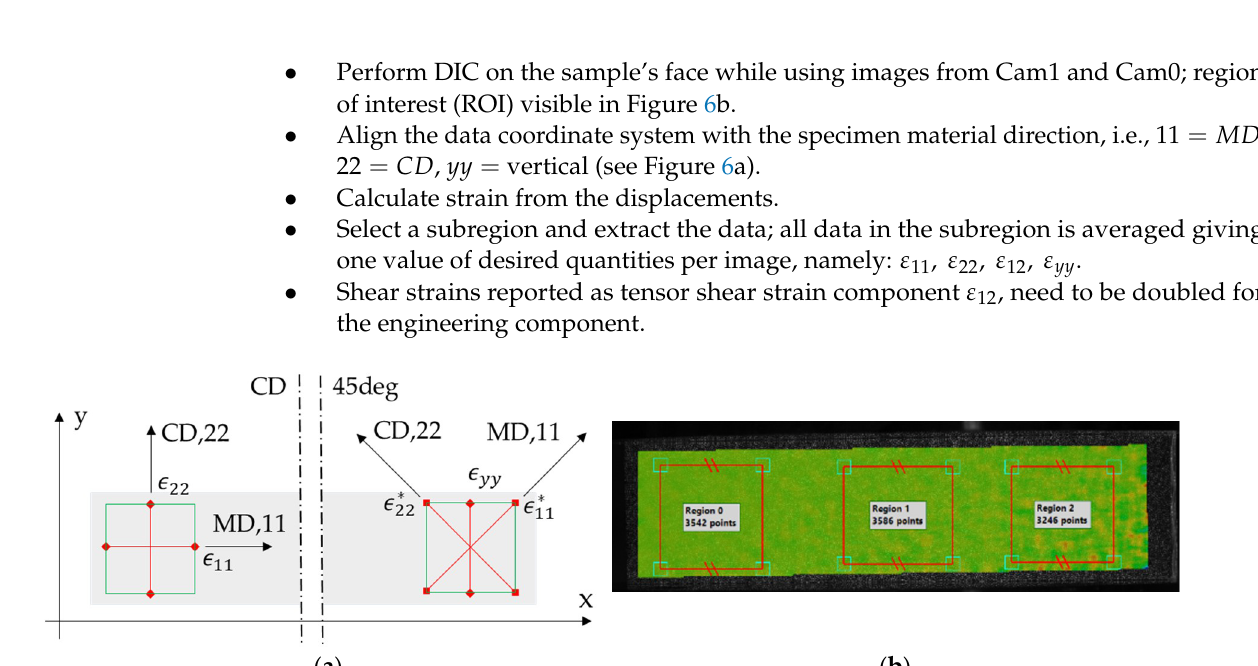
Figure 6. Virtual optical gauges ( a ) sample in CD and in 45°; ( b ) ROI visualization. The * denotes a material orientation in the sample cut in the 45°.